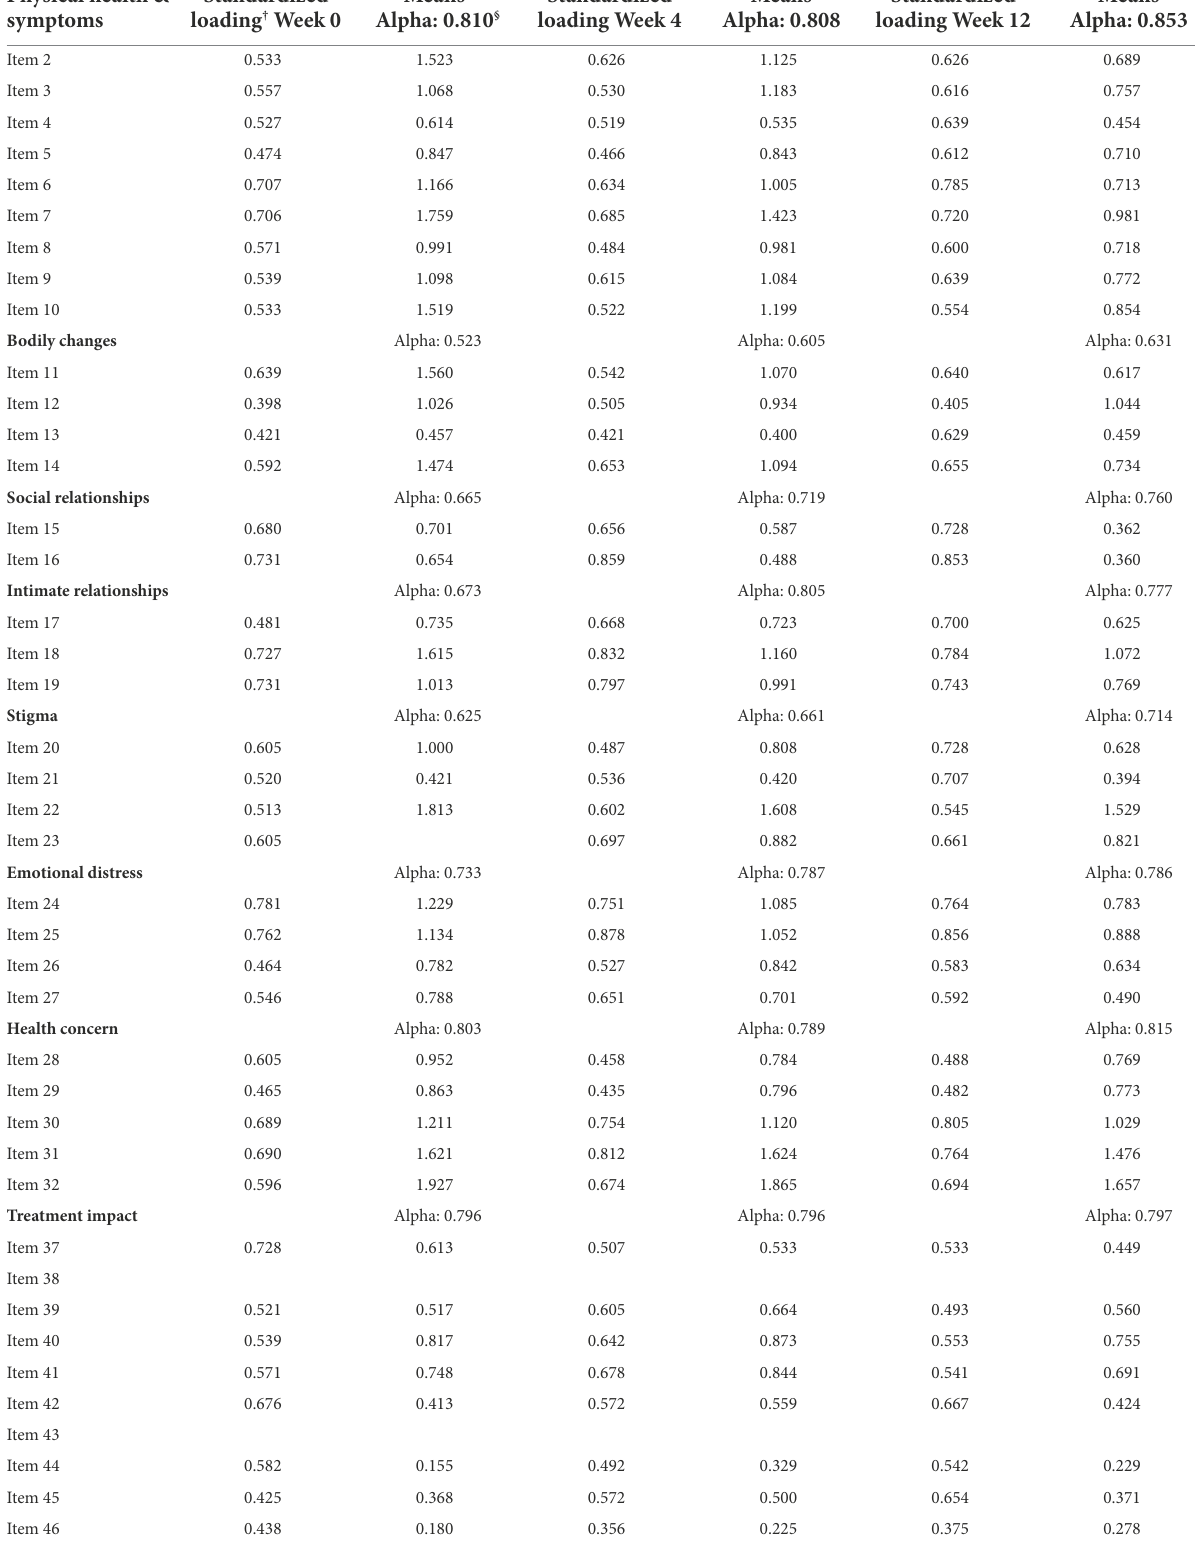
TABLE 2 Confirmatory factor analyses: eight PROQOL-HIV/TB subscales, factor loadings, reliability estimate and goodness-of-fit indices. Physical health &